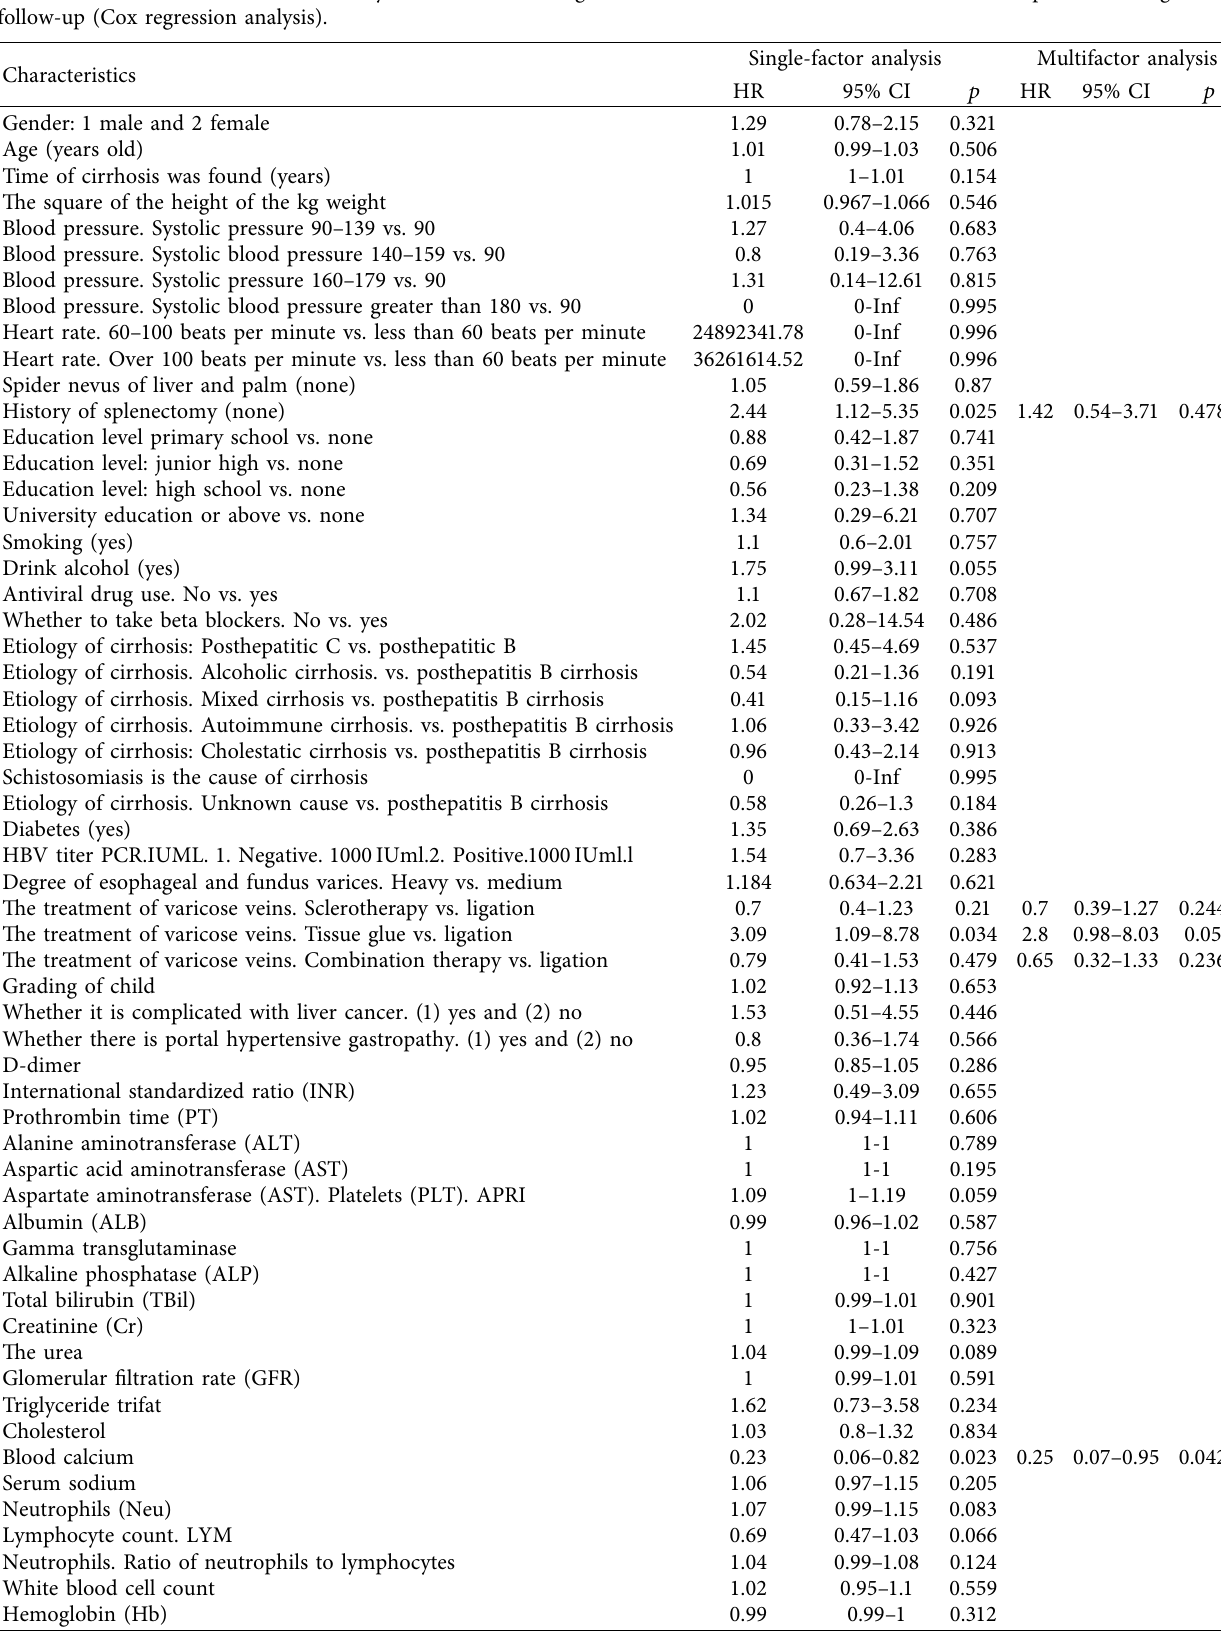
Table 5: Univariate and multivariate analyses of factors afecting the occurrence of cholelithiasis in liver cirrhosis patients during the late follow-up (Cox regression